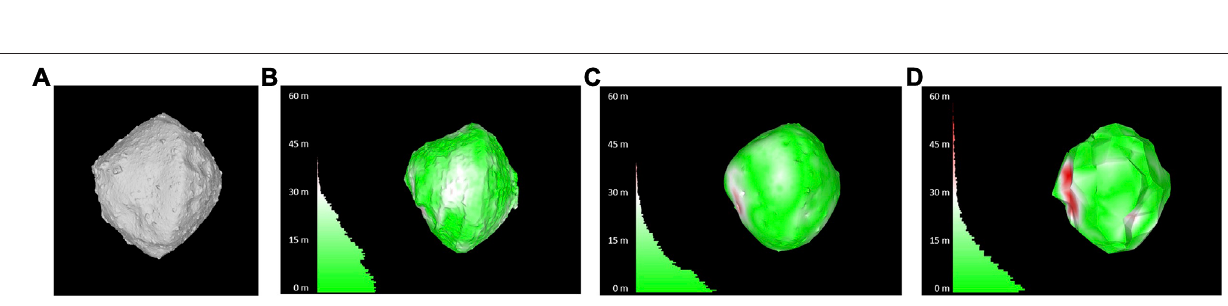
Frontiers in Robotics and AI |